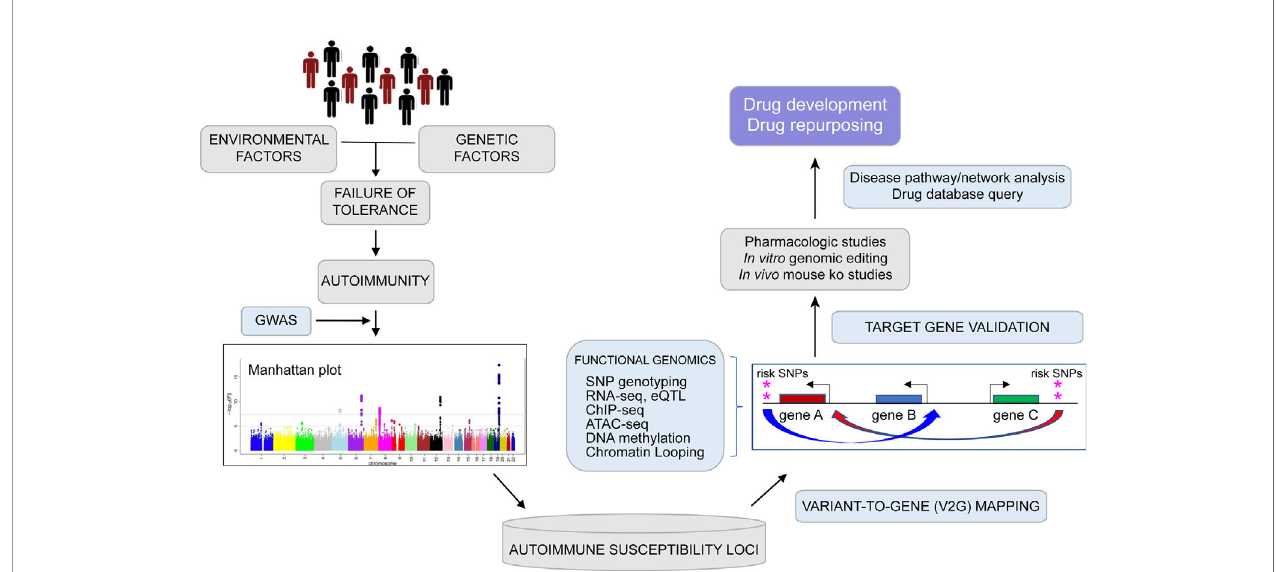
FIGURE 1 | From genome to function: Graphical depiction of a pipeline leveraging genetic and epigenetic datasets to connect auto-immune disease associated variants to their target genes with focus toward drug development and repurposing. Genome wide association studies (GWAS) can identify multiple common genetic variants that confer risk for various diseases (as shown by Manhattan plot) including auto-immune disorders, but which variants are causal and which genes are involved remains largely unknown. Expression quantitative trait locus (eQTL) studies, high-resolution analysis of epigenomic and spatial organization can connect potentially functional SNPs with expression of putative disease genes in relevant cell types. Disease pathway exploration and experimental validation may lead to drug development and repurposing